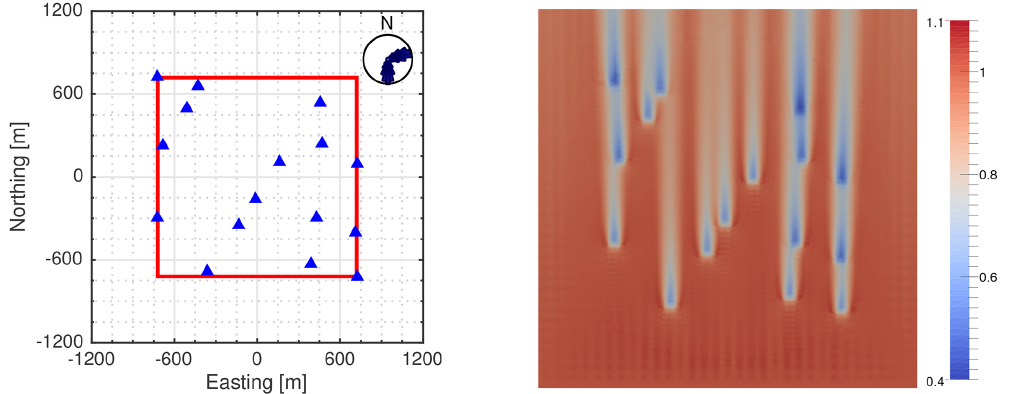
Figure 8. Optimal layout (left) and flow field (right) for the boomerang test case with the wind rose binned into 36 inflow directions and a uniform hub-height velocity of 8ms − 1 . The wind rose is shown in the upper right corner of the left panel, and the site boundary is shown by a solid red line. Turbine locations are denoted by blue triangles. The flow field in the right panel is normalized by the incoming hub-height velocity of 8ms − 1 and shows results for an inflow wind from the south.